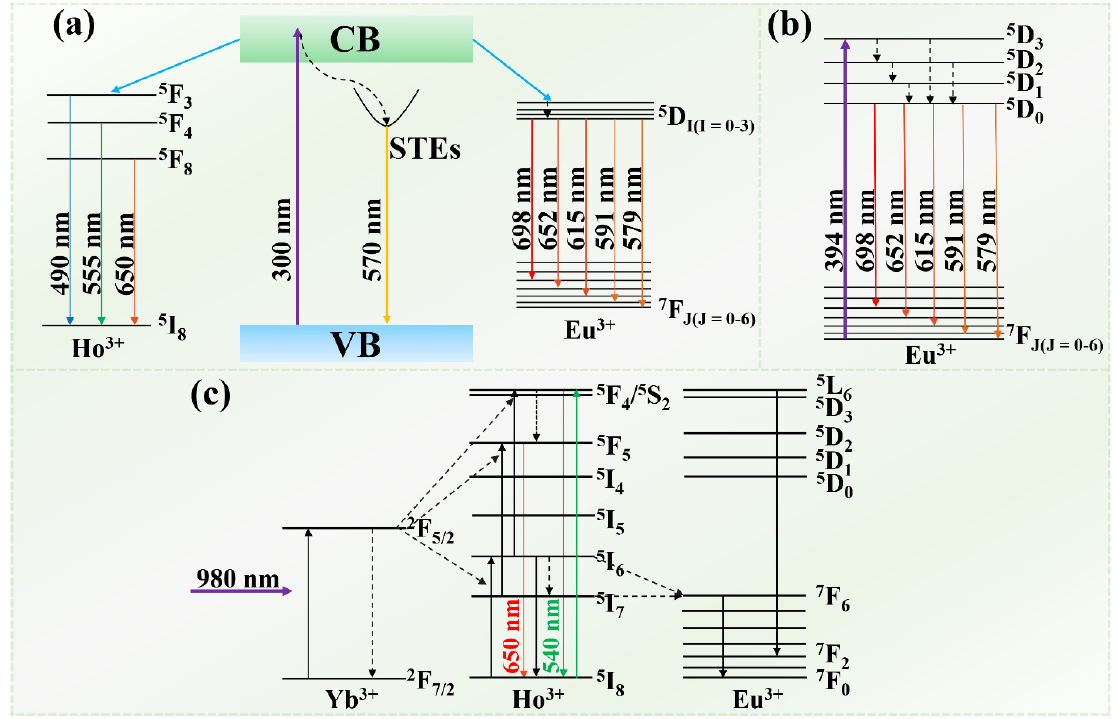
Figure 6. Energy-level diagrams of Cs 2 Ag 0.3 Na 0.7 InCl 6 : Yb 3+ /Eu 3+ /Ho 3+ and the proposed lumines- cence mechanism ( a ) λ ex = 300 nm ( b ) λ ex = 394 nm ( c ) λ ex = 980 nm.